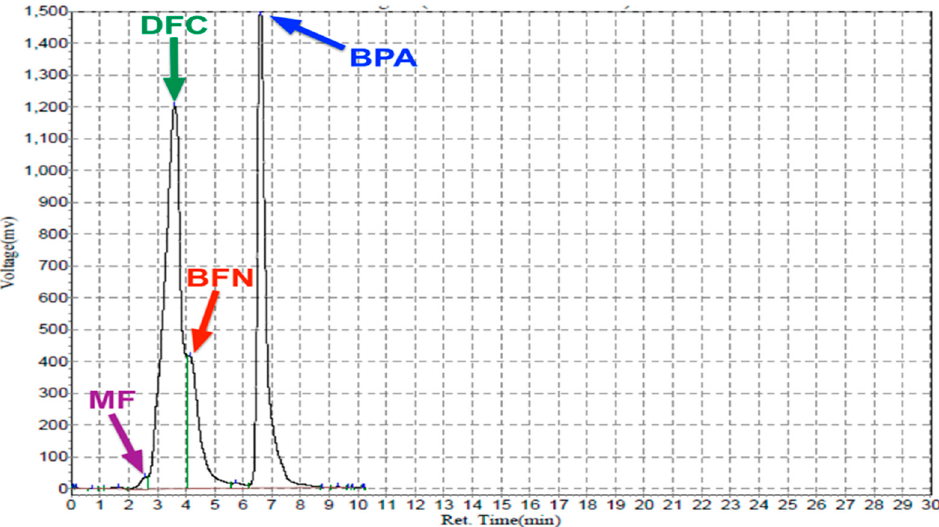
Figure 4. HPLC analysis of a mixture of MF (200 ppm) at 2.5 min, DFC (200 ppm) at 3.6 min, BFN (200 ppm) at 4.1 min and BPA (100 ppm) at 6.6 min. Mobile phase: CH 3 CN/MeOH/DDW (1:1:1 v/v); flow rate, 0.8 mL/min; UV detection at 200 nm.